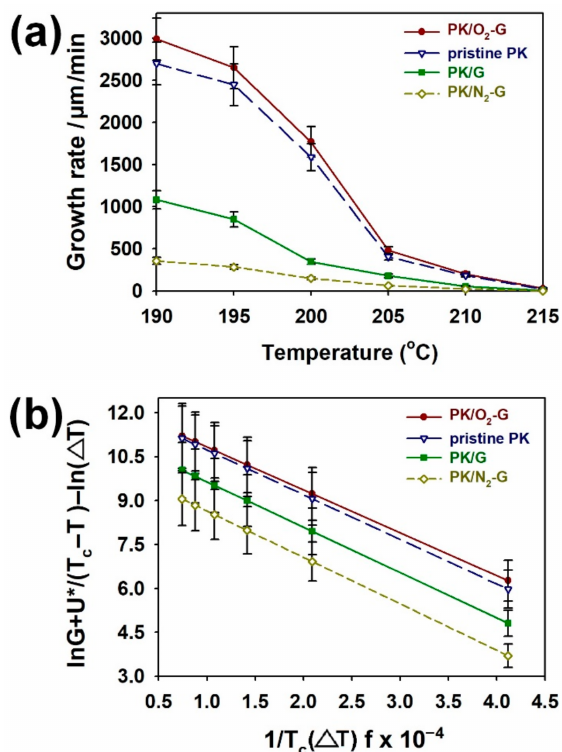
Figure 6. ( a ) Spherulite growth rate of PKs after isothermal crystallization at different temperatures.